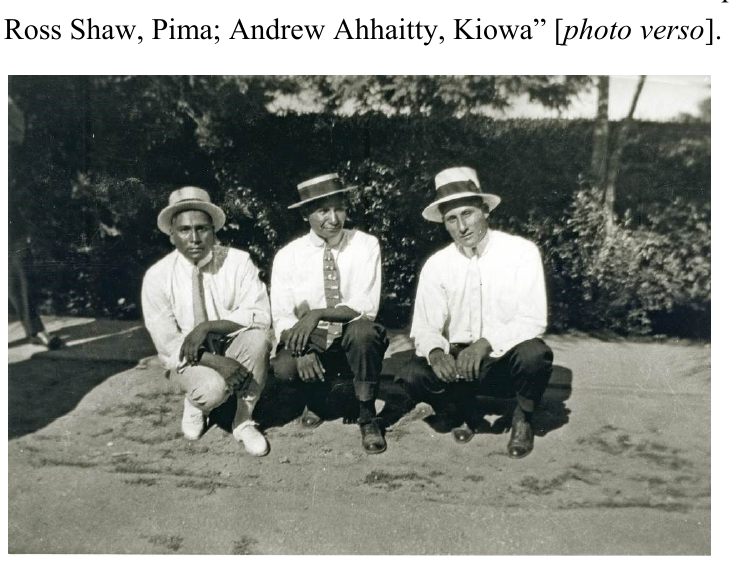
Figure 11. Easchief Clark; Ross Shaw; Andrew Ahhaitty. ca . 1914–1917. Photograph